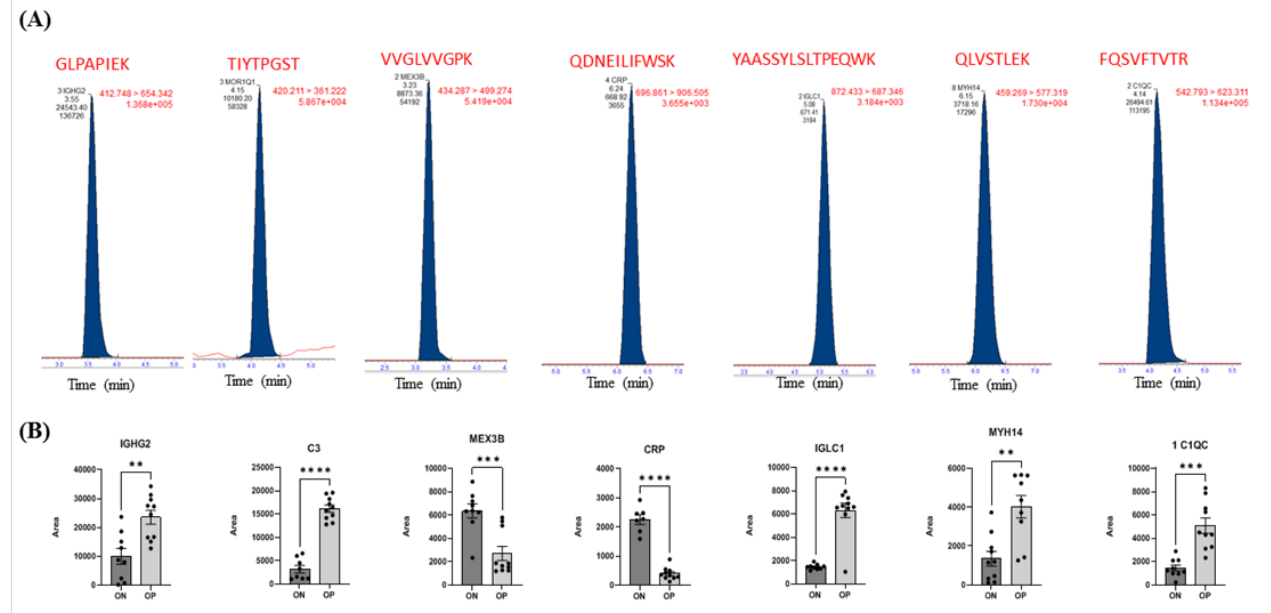
Figure 5. Validation of the expression of selected proteins in the ON and OP groups using multiple reaction monitoring (MRM). ( A ) Representative MRM chromatograms for protein signature peptides selected from the Skyline Software and confirmed using PeptideAtlas. ( B ) Scatter plots with bar-graph for the expressions of selected proteins. The differences between the study groups were evaluated using an unpaired t -test with significance set at p -value < 0.05 (denoted by *) <0.01 (denoted by **), <0.001 (denoted by ***), and <0.0001(denoted by ****).